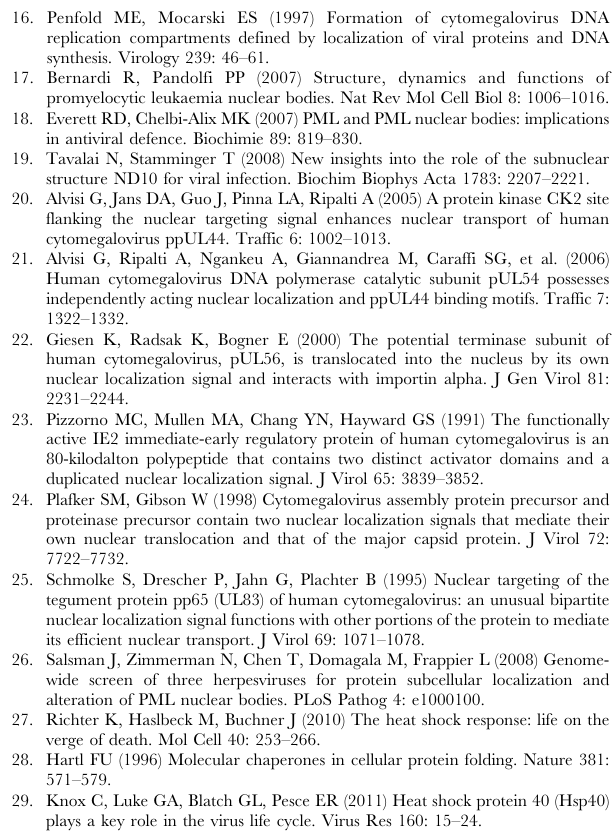
Figure S6 Effect of the expression of DNAJB6 on the distribution of untagged UL70 in nuclear and cytoplas- mic fractions. Different cells (e.g. parental U251 cells, U251-6a and U251-6b cells, and 6a- and 6b-siRNA treated cells) were transfected with pCMV-UL70 in the absence and presence of siRNAs. At 48 hours posttransfection, cells were infected with HCMV (MOI =1). At 48–72 hours postinfection, cells were harvested and separated into nuclear and cytoplasmic fractions. Equivalent amounts of each fraction were analyzed by immuno- blotting with the anti-UL70 antibody. The purity of the nuclear and cytoplasmic fractions was assayed by immunoblotting with anti-histone H1 and anti-Actin, respectively. The membranes were reacted with antibodies and subsequently stained using a Western with a STORM840 PhosphorImager (GE Healthcare) or a Gel Documentation Station (BioRad, Hercules, CA) [54,55]. A dilution series of the samples was analyzed and the results were compared in order to accurately determine the protein levels. Quantitation was performed in the linear range of protein detection [54,55]. The experiments were in duplicate and repeated three times. The standard deviation is indicated by the error